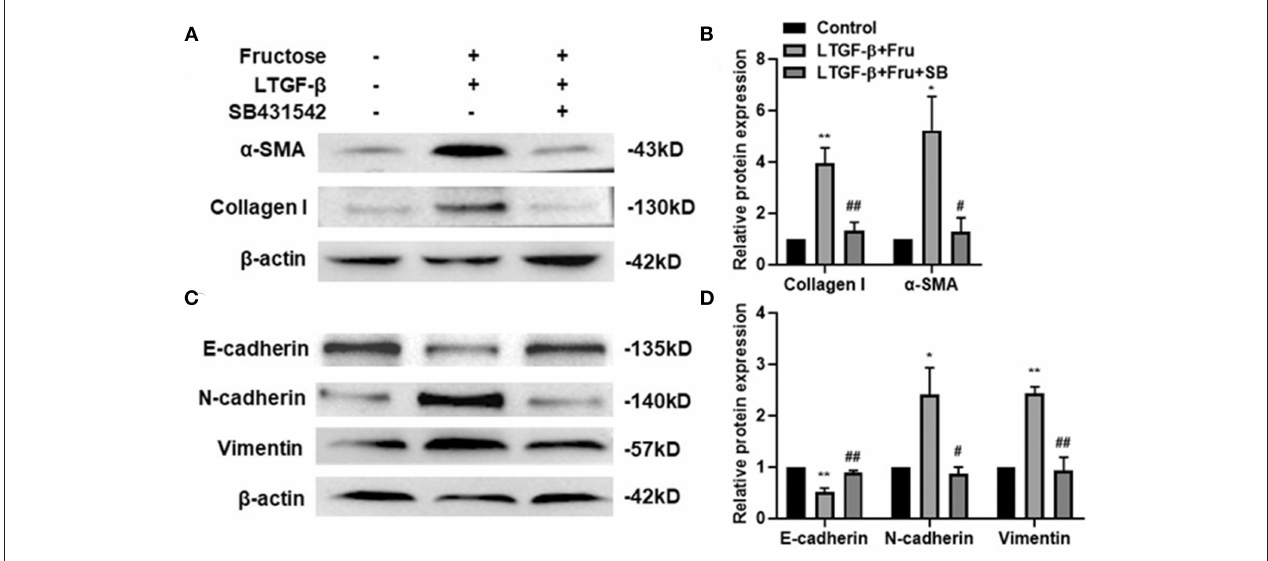
FIGURE 7 | Effect of SB431542 on fibrotic- and EMT- related protein expression of A549 cells induced by fructose and latent TGF- β 1. A549 cells were treated under the indicated conditions, and then the expression of collagen I, (A and B) α -SMA, (A and B) N-cadherin, (C and D) E-cadherin, (C and D) and vimentin (C and D) was assessed by Western blot. Data are set as the Mean ± SEM ( n = 3). The relative value was set as fold induction to that of the control set at 1, normalized to β -actin. Comparisons between groups were achieved using a one-way ANOVA by Tukey’s test. * p < 0.05 and ** p < 0.01 vs. control group; # p < 0.05, ## p < 0.01, compared with the LTGF- β 1 + Fru group. Control, 0mM fructose; LTGF- β 1 + Fru, latent TGF- β 1 + 10mM fructose; LTGF- β 1 + 10mM Fru + SB, latent TGF- β 1 + 10mM fructose + SB431524.